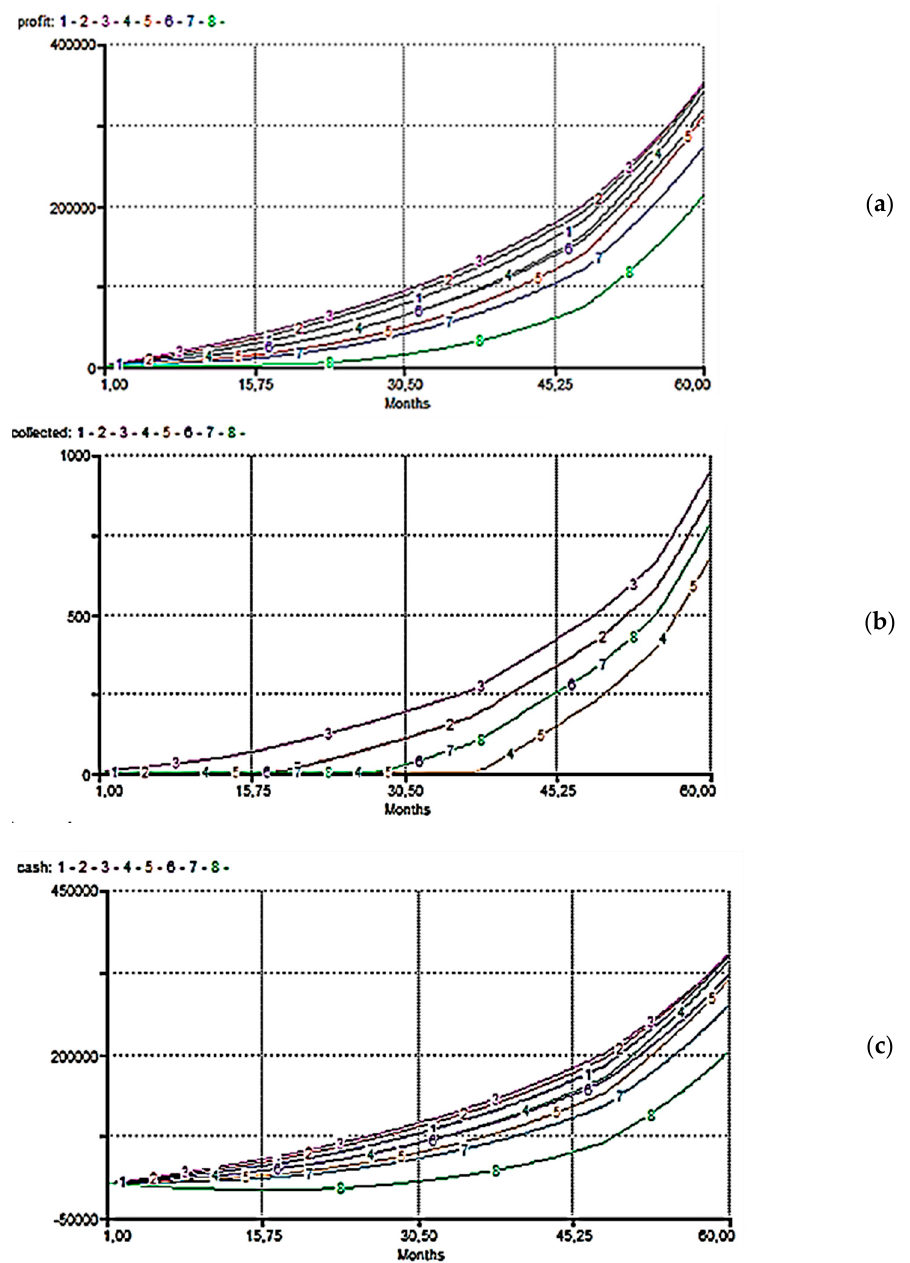
Figure 6. Simulation results of the eight examined scenarios as produced by ithink. ( a ) Evolution of profitability; ( b ) Evolution of currying inventories (collected); ( c ) Cash flow in the eight scenarios.